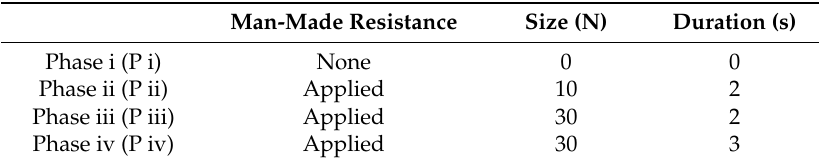
Table 6. Resistance force and duration of four phases in the